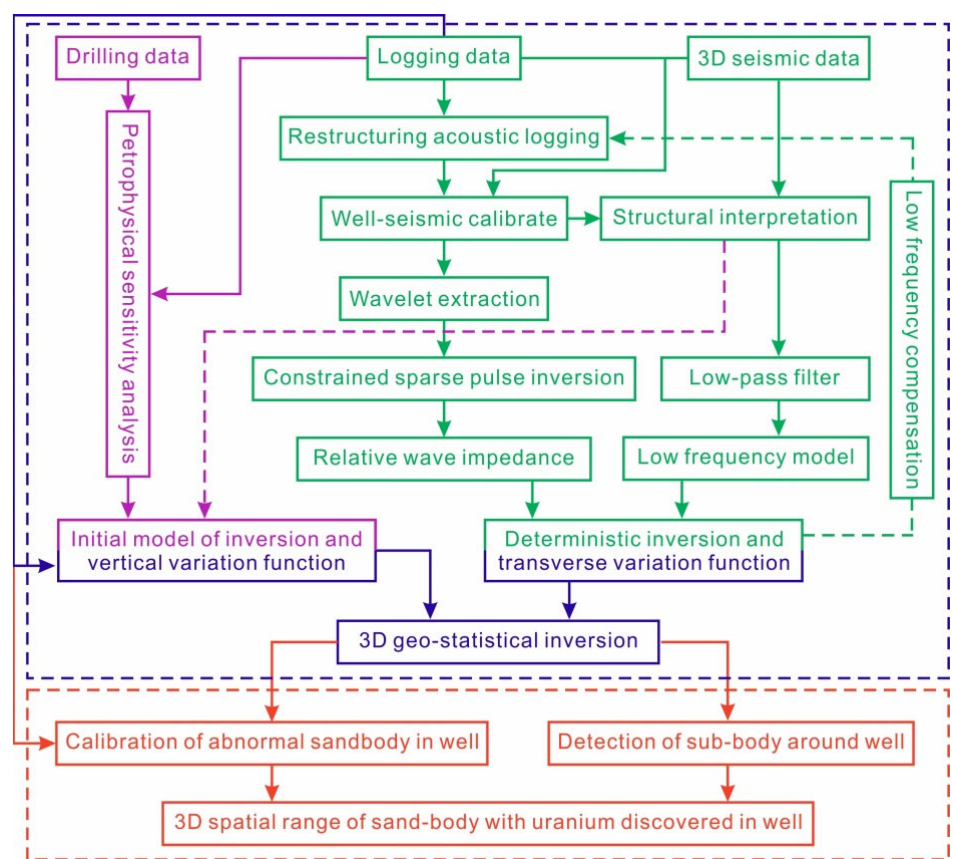
Figure 2. The workflow of searching for the sandstone type uranium deposits using historical oil wells and 3D seismic data in petroliferous basins.